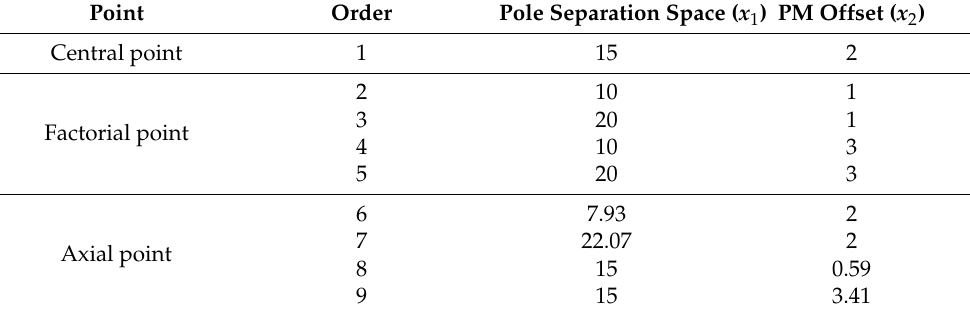
Table 4. Experimental points.